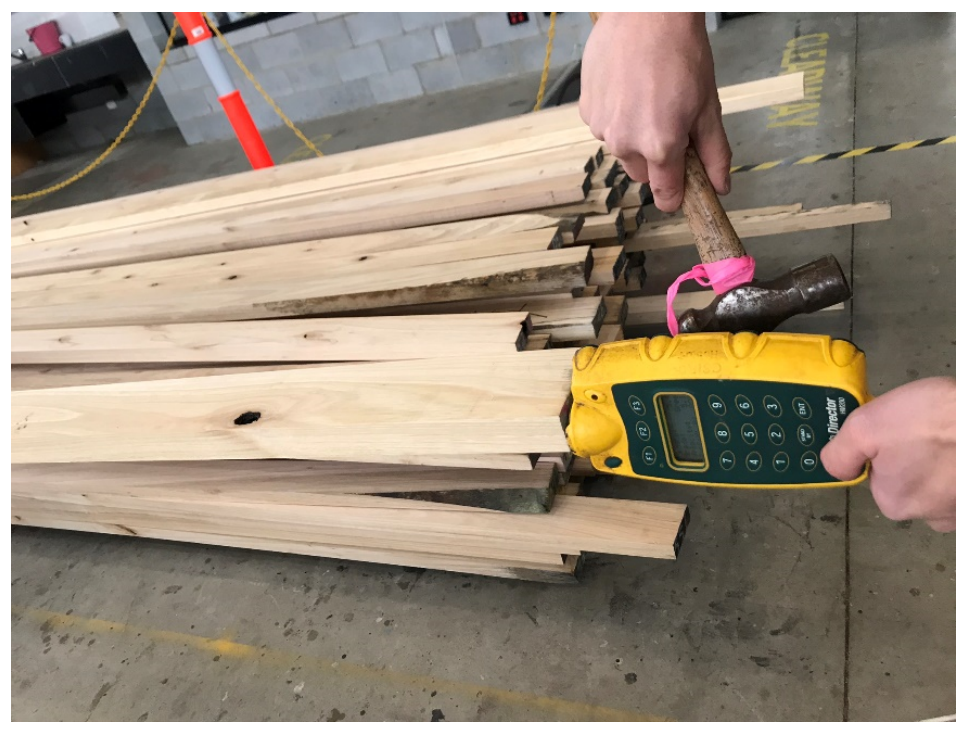
Figure 3. Acoustic wave velocity measurement of the E. nitens boards.